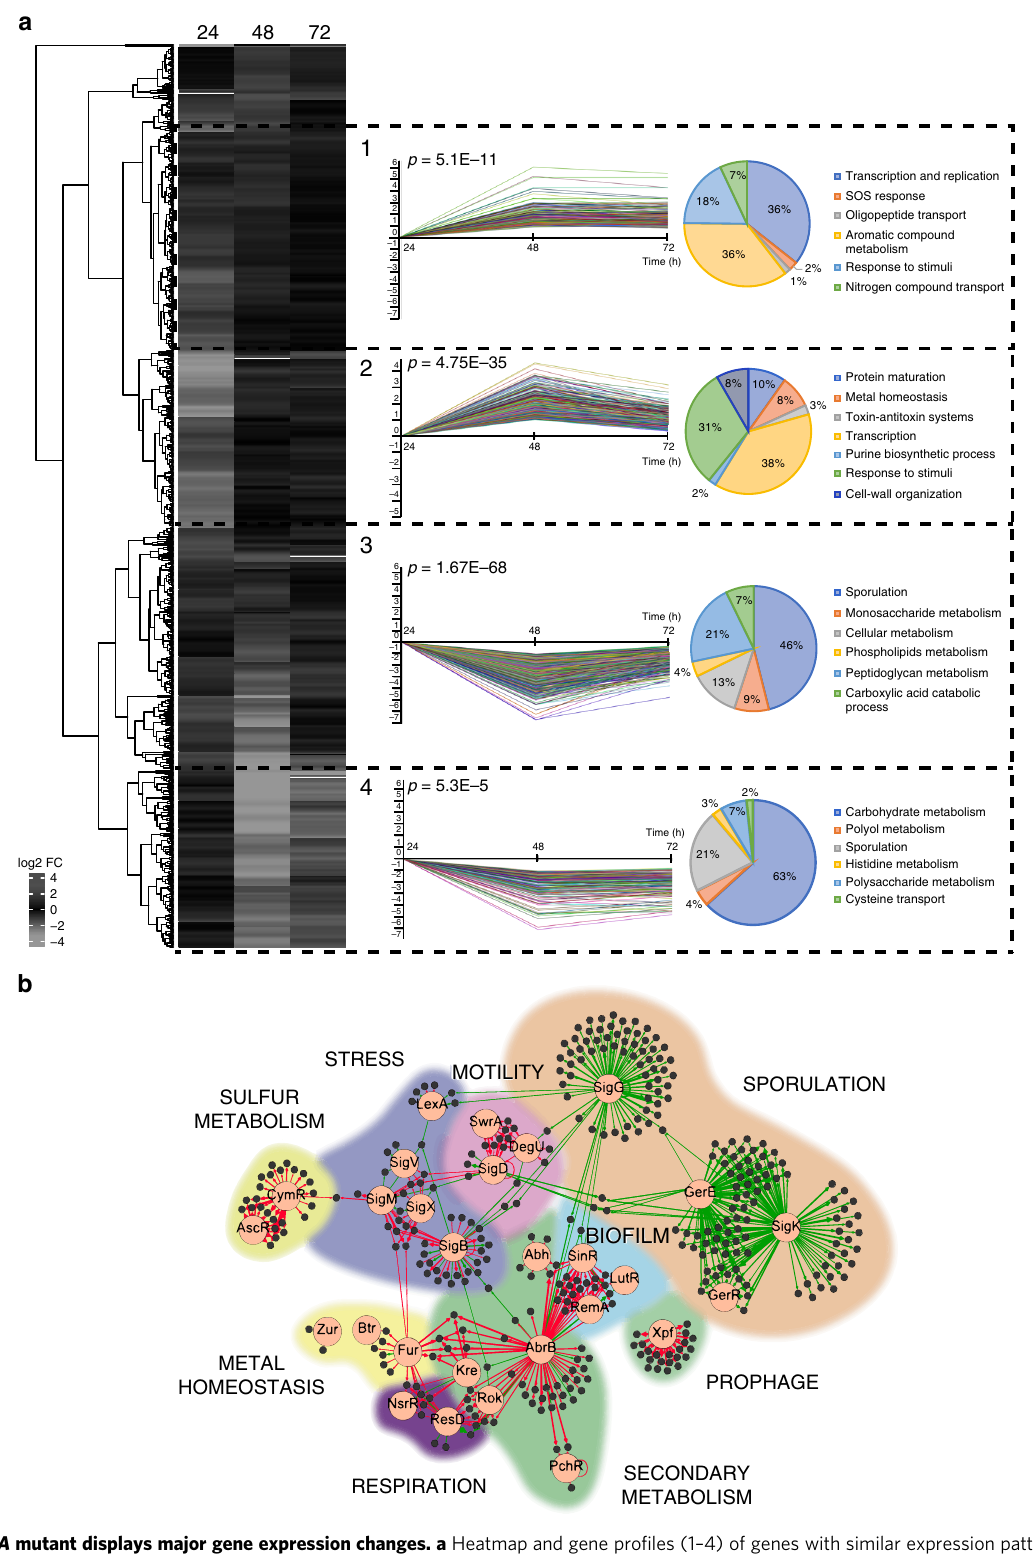
Fig. 2 The tasA mutant displays major gene expression changes. a Heatmap and gene pro fi les (1 – 4) of genes with similar expression patterns. Genes in the same pro fi le are categorized (right) according to their gene ontology (GO) terms. Each gene pro fi le represents statistically signi fi cant genes. Statistical signi fi cance was assessed by a χ 2 test comparing the number of clustered genes with the expected theoretical number of genes if gene distribution were random. In the heatmap, induced genes are colored in dark gray and repressed genes in light gray. b Differentially expressed genes at 72 h clustered into different regulons. The bigger circles indicate de main regulator of that regulon, which is surrounded by arrows pointing to smaller circles that are the differentially expressed genes. The thickness of the arrows indicates expression levels. The color in the arrows indicates induction (red) or repression